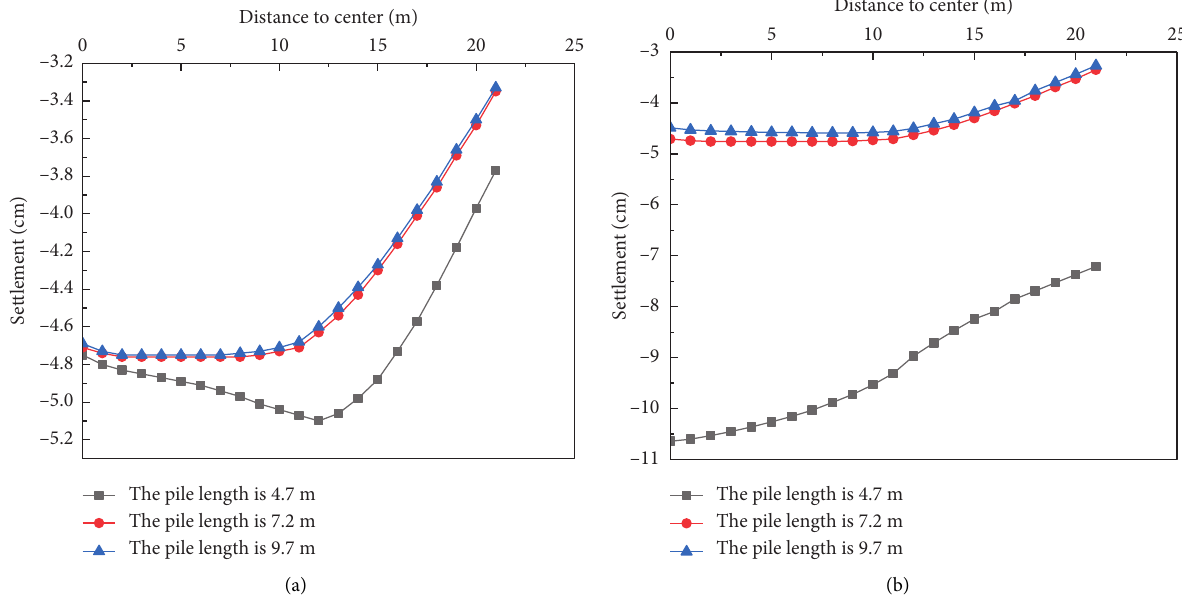
Figure 15: Postconstruction settlement diagram of the subgrade surface widened under varying piles lengths. (a) Variations in the pile length under the existing road slope. (b) Variations in the pile length under the existing subgrade and new